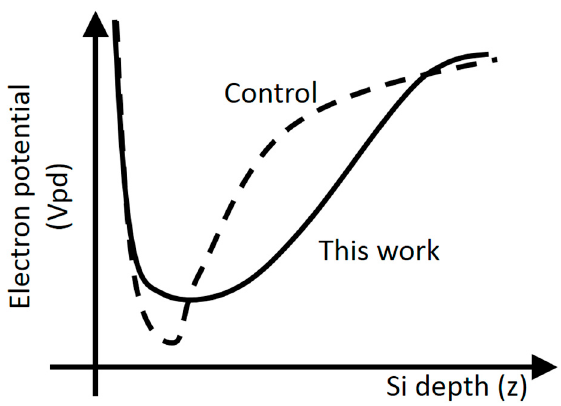
Figure 9. Photodiode potential profile. Dashed line is based on control pixel, and solid line is based on the pixel in this experiment.